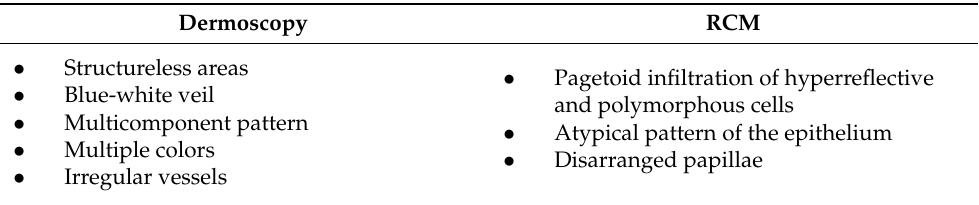
Table 3. Main dermoscopic and RCM features of mucosal melanoma.